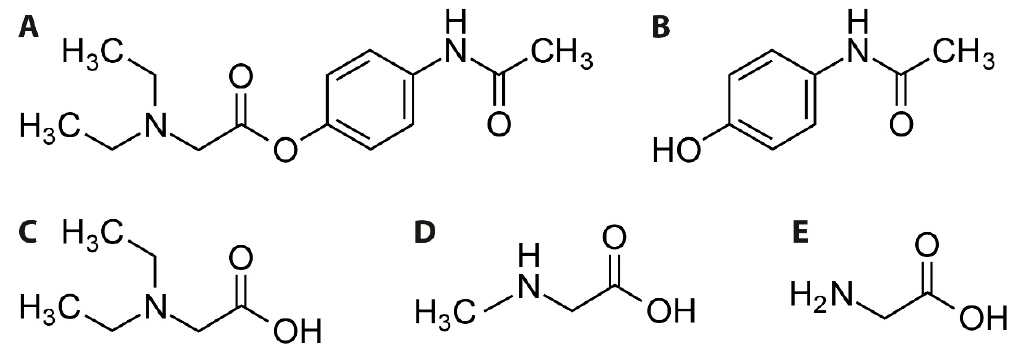
Figure 1. Chemical structure of ( A ) propacetamol, ( B ) acetaminophen, ( C ) N , N -diethylglycine (DEG), ( D ) sarcosine, ( E ) glycine. Propacetamol is hydrolysed to acetaminophen and DEG, which shares structural similarities to the neurotransmitter glycine.